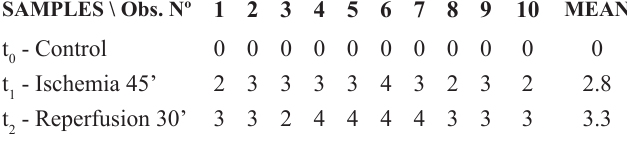
TABLE 1 - Histopathology of Group 1 animals with ischemia without ischemic preconditioning.